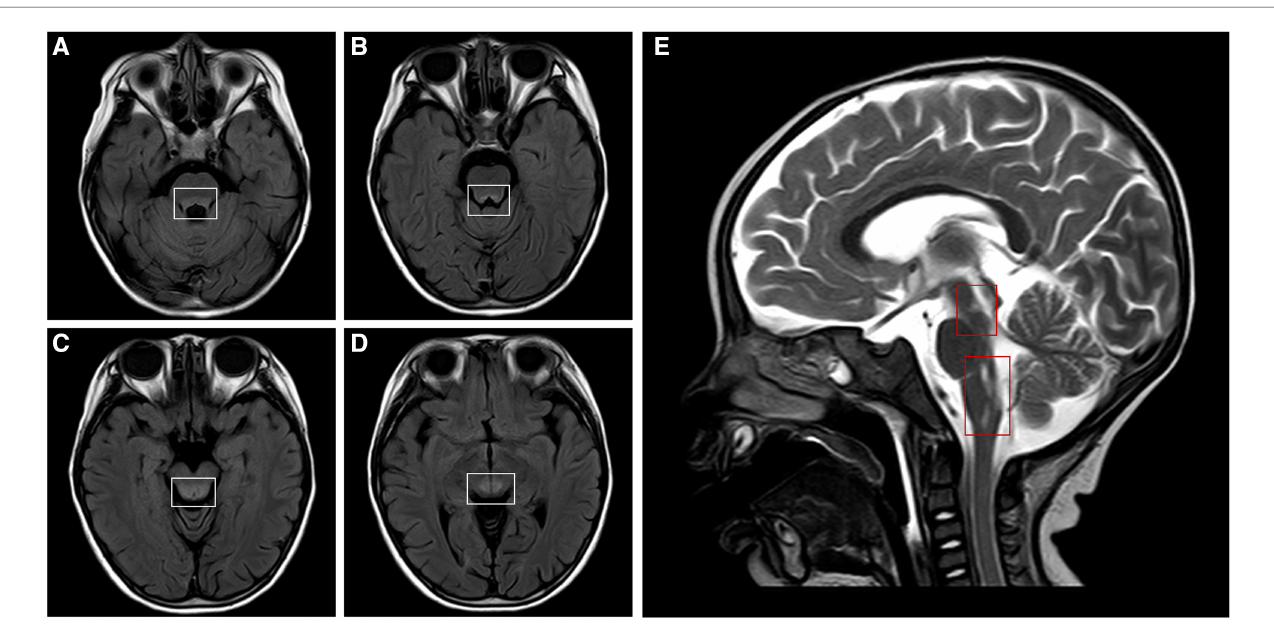
FIGURE 3 Cranial MRI of the patient. Cranial MRI shows bilateral symmetrical lesions of abnormal signal intensity around the third ventricle, pons, dorsal medulla oblongata, and in the gray matter around the dorsal aqueduct. Axial T2-FLAIR images ( A – D , white frames) and a sagittal T2-weighted image ( E , red frames) show the lesions. MRI, magnetic resonance imaging; FLAIR, fl uid attenuated inversion recovery.